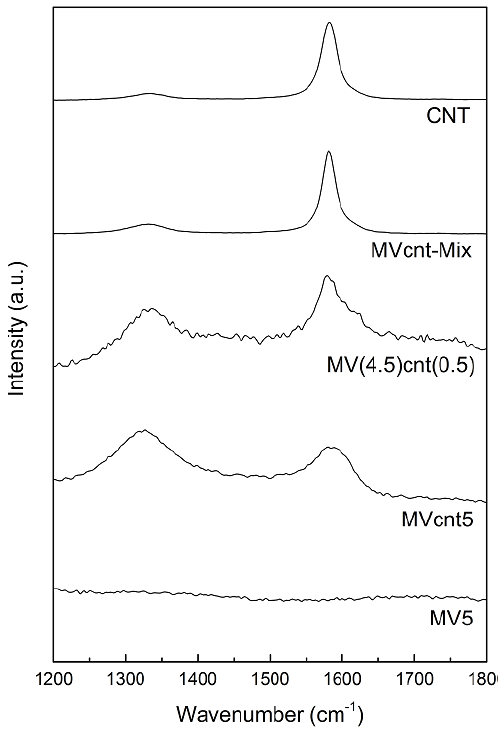
Figure 5. Raman spectra of MgH 2 -based composites and